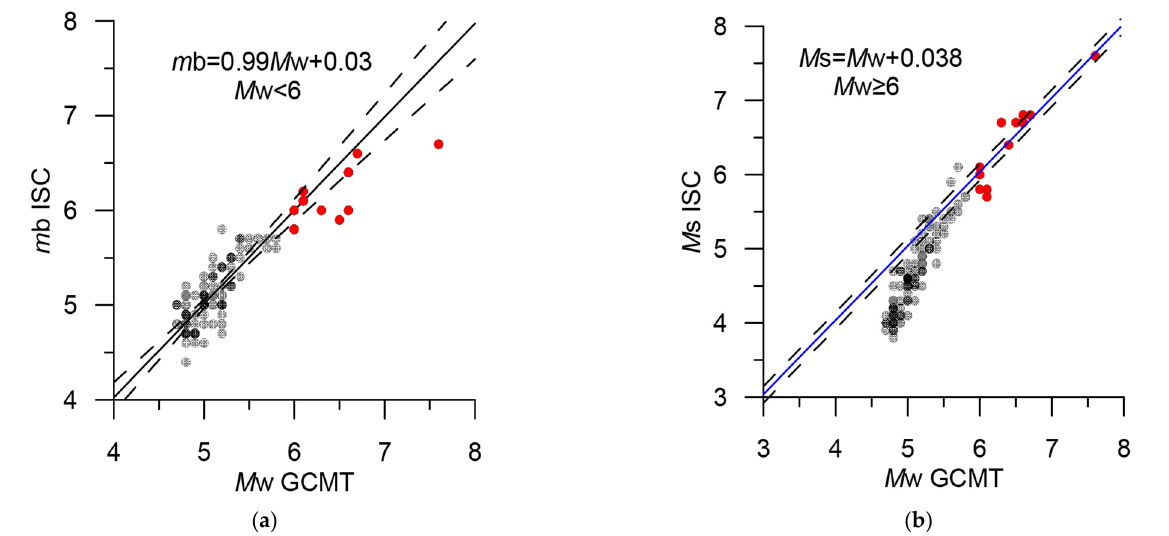
Figure 13. Correlation ratios of GCMT and ISC magnitudes: ( a ) M WGCMT and mb ISC for M W < 6.0 and ( b ) M W GCMT and M S ISC for M W ≥ 6.0. The dashed lines show 95% confidence intervals. The events with an M W of ≥ 6.0 are highlighted in red. Table 5. Strong earthquakes in the Eastern